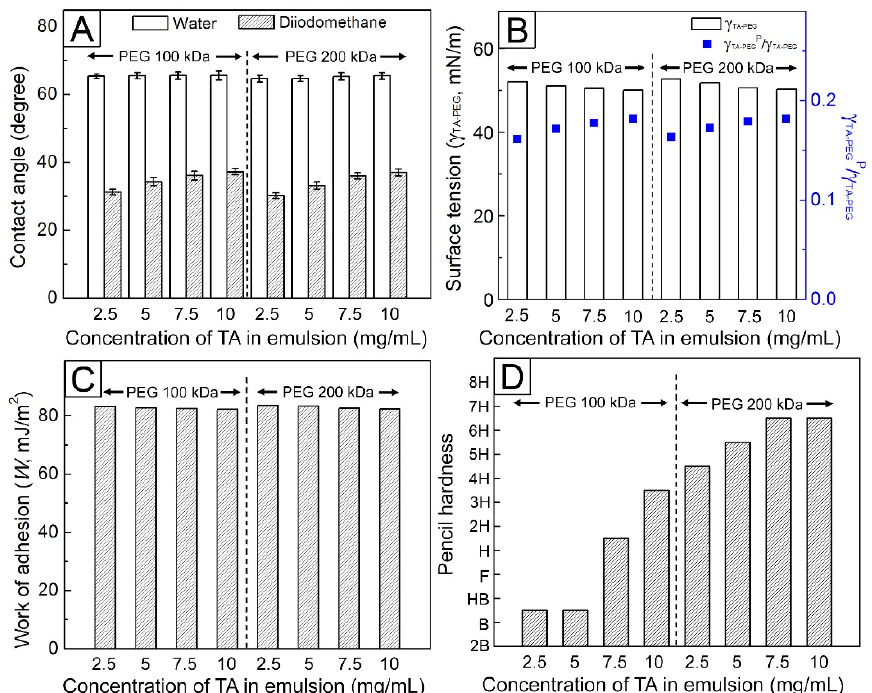
Figure 4. ( A ) Contact angles of water and diiodomethane droplets on the coating layers made using the TA–PEG emulsions containing different concentrations of TA. ( B ) Surface tension ( γ TA-PEG ) and polar contribution ( γ TA-PEGP / γ TA-PEG ) of coating layers made using the TA–PEG emulsions containing different concentrations of TA. ( C ) Work of adhesion between the TA–PEG coating layer and PMMA substrate in the samples. ( D ) Hardness of the TA–PEG coating layers made using the TA–PEG emulsions containing different concentrations of TA.